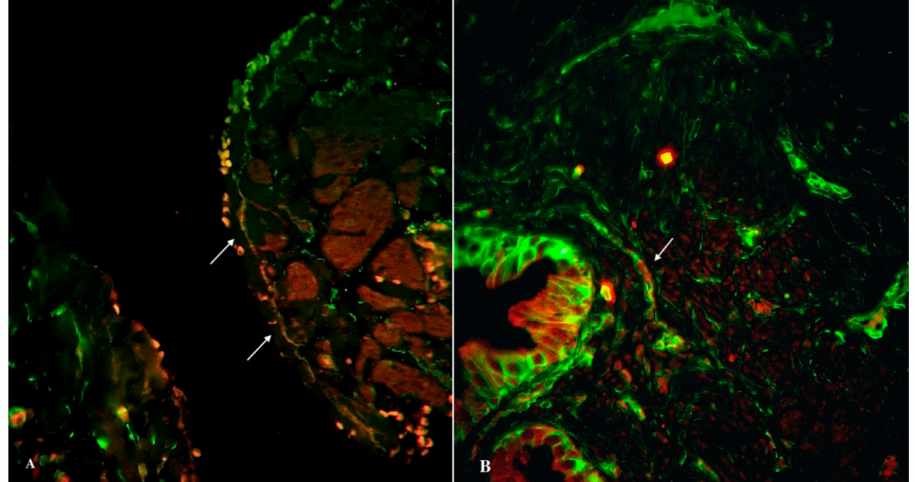
Figure 4. Double immunolabelling of human oviduct stained for c-kit (red, Alexa Fluor 594) and vi- mentin (green, Alexa Fluor 488) in the control ( A ) and study ( B ) groups. The doubly immunopositive cell with an oval-shaped body and long cellular prolongation was identified as a telocyte (marked by an arrows). Total magnification: ×